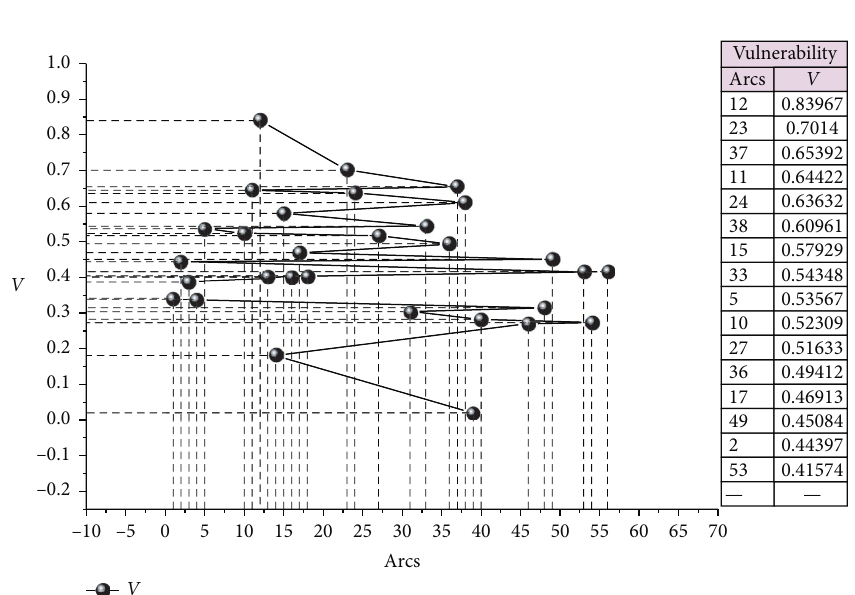
Figure 8: Vulnerability statistics after comprehensive